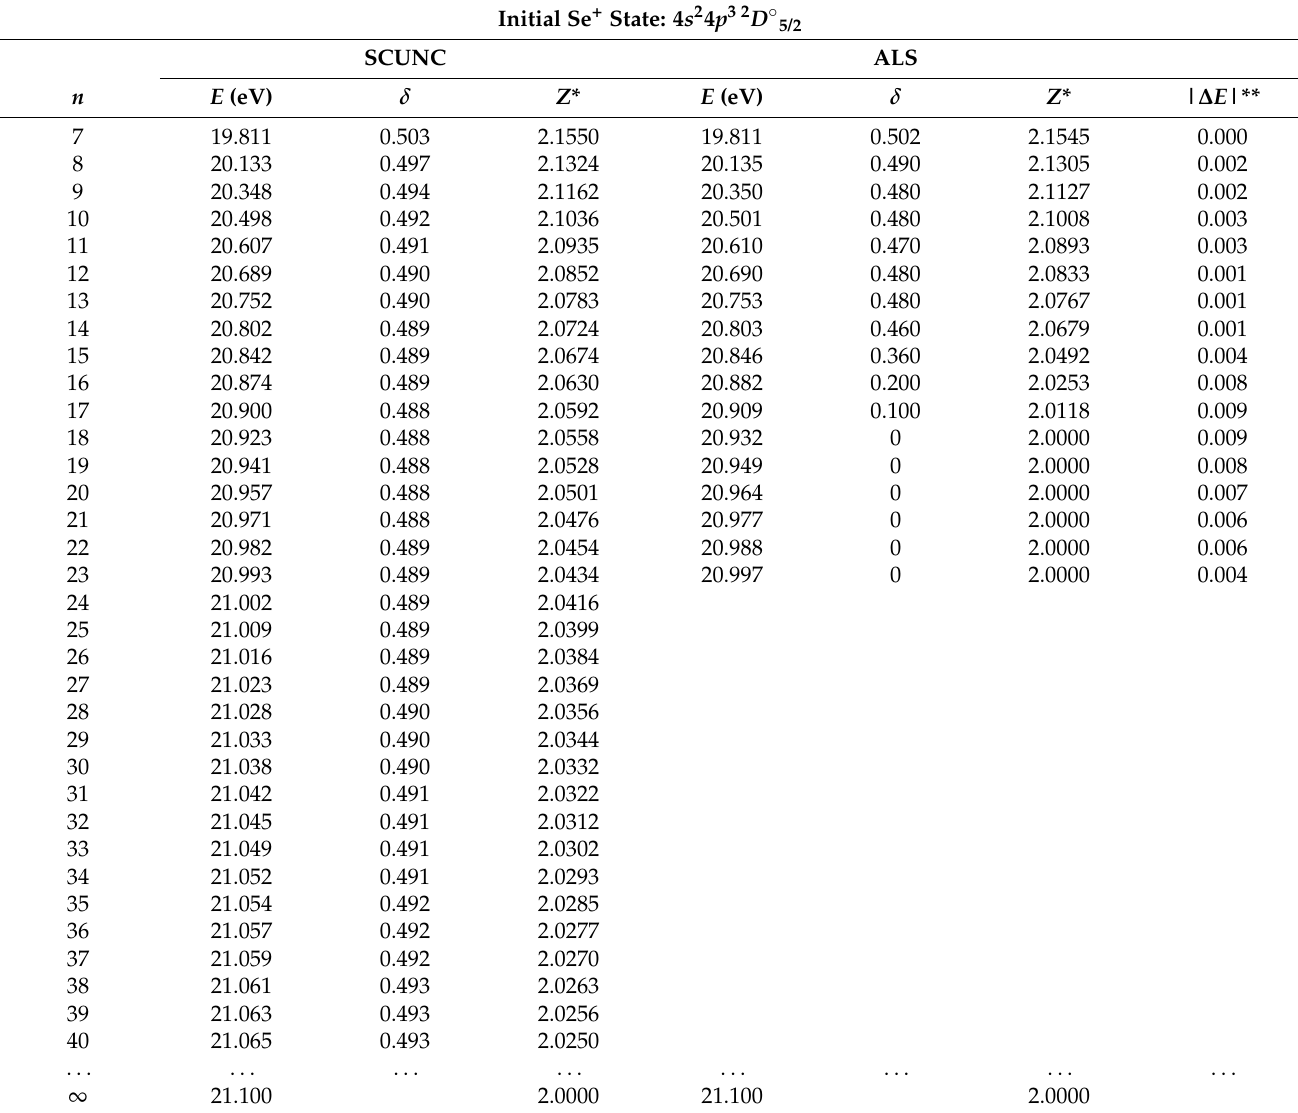
Table 10. Energy resonances ( E ), quantum defect ( δ ) and effective charge ( Z *) of the 4 s 2 4 p 2 ( 1 D 2 ) ns ( 2 D ) Rydberg series originating from the 4 s 2 4 p 3 2 D ◦ 5/2 metastable state of Se + converging to the 1 D 2 series limit in Se 2+ . The present results (SCUNC) are compared with the experimental data from ALS measurements [6]. The uncertainties in the experimental energies are stated to be ± 0.010 eV, f 1 ( 1 D 2 ; 2 D ◦ − 0.927 ± 0.050 with ν = 5/2 ) =